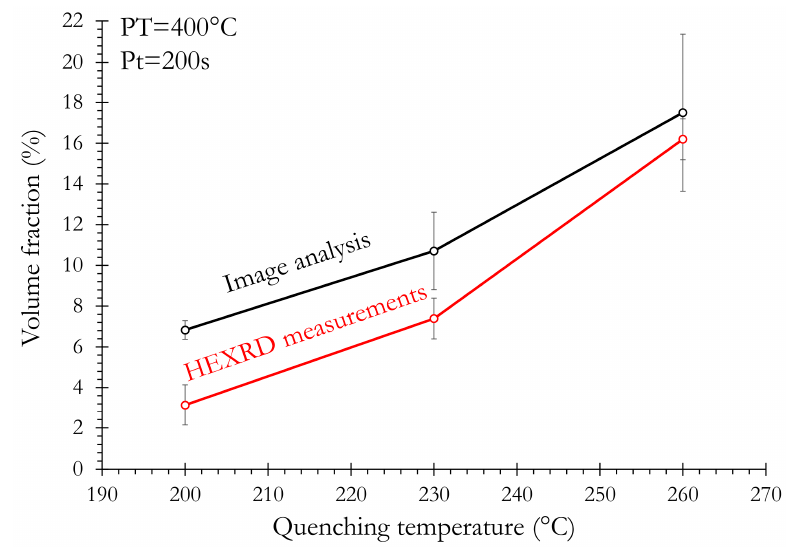
Figure 11. Comparison of bainite fraction measured by image analysis (black curve) and the new BCT phase measured by HEXRD (red curve) at the end of the partitioning step for the three QTs.